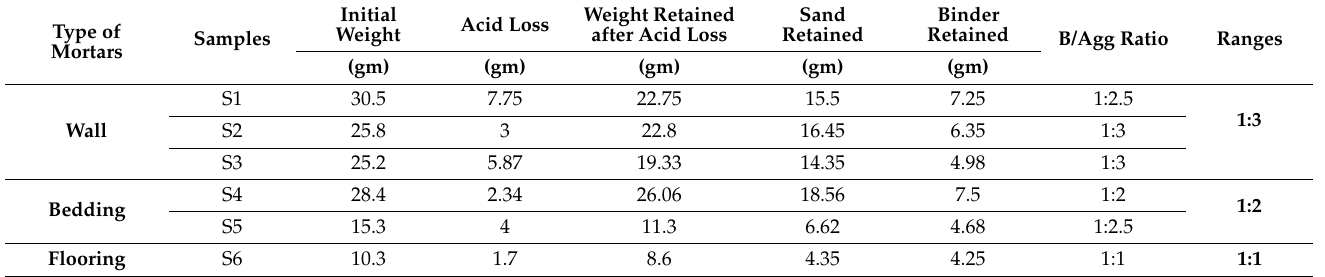
Table 2. Binder/Aggregate (B/Agg) ratio for palace lime mortars (Source: Shivakumar et al., 2020)